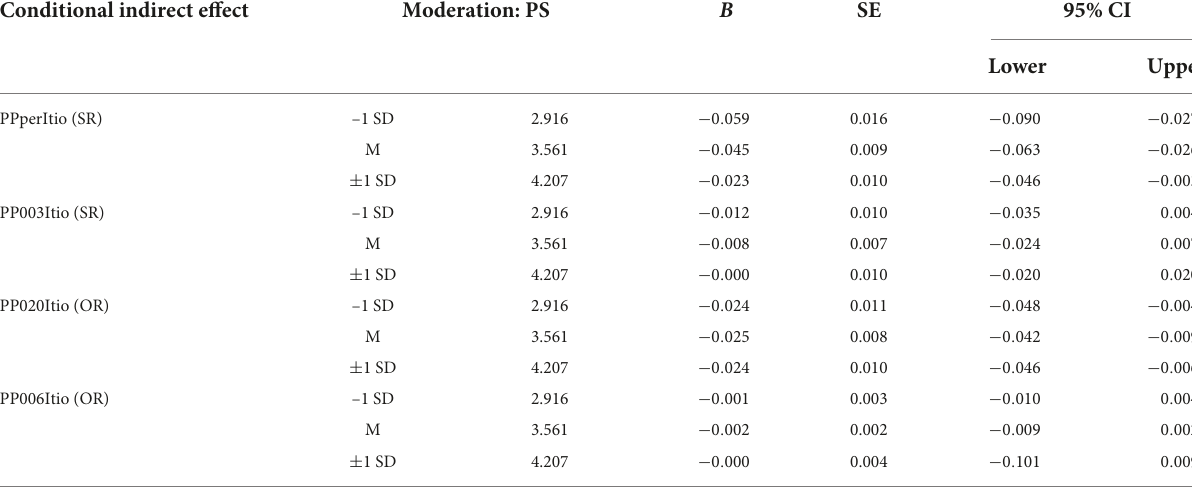
TABLE 8 Moderated mediation conditional indirect effect of partner protectiveness on receiving useful knowledge. Conditional indirect